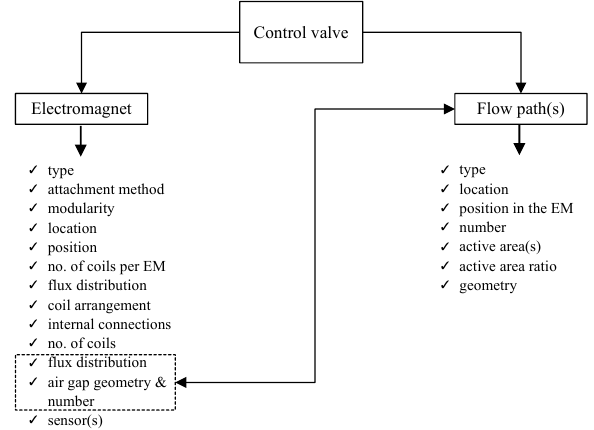
Figure 3. Layout: actuator decomposition.